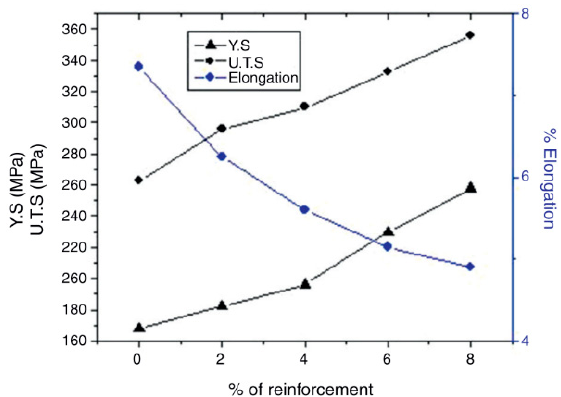
Figure 13. The effect of varying reinforcement on the yield strength